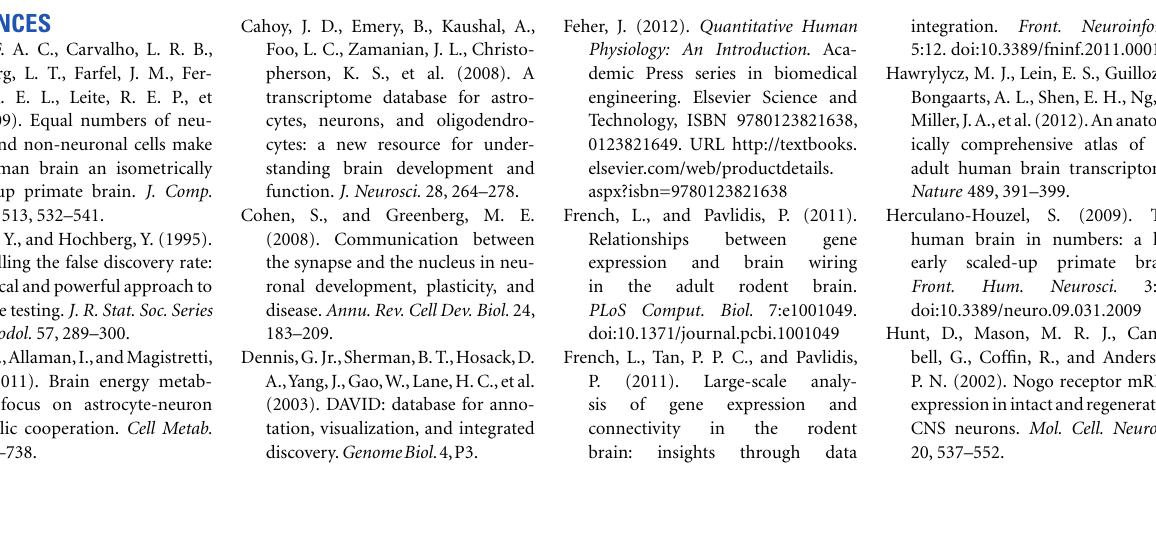
Figure S1 | H0351.2001 cell type marker enrichment ROC curves. Figure S2 | H0351.2002 cell type marker enrichment ROC curves. Figure S3 | Mouse cell type marker enrichment ROC curves. Figure S4 | Correlation distribution between homologous genes that are expressed . Correlation distribution is skewed toward the positive compared to random where human gene labels were shuffled without replacement.The mean correlation is 0.074. Figure S5 | Gene-gene correlation cell type marker enrichment ROC curves. Expression data were mean-centered scaled. Figure S6 | Relative expression levels of homologous astrocyte markers across brain